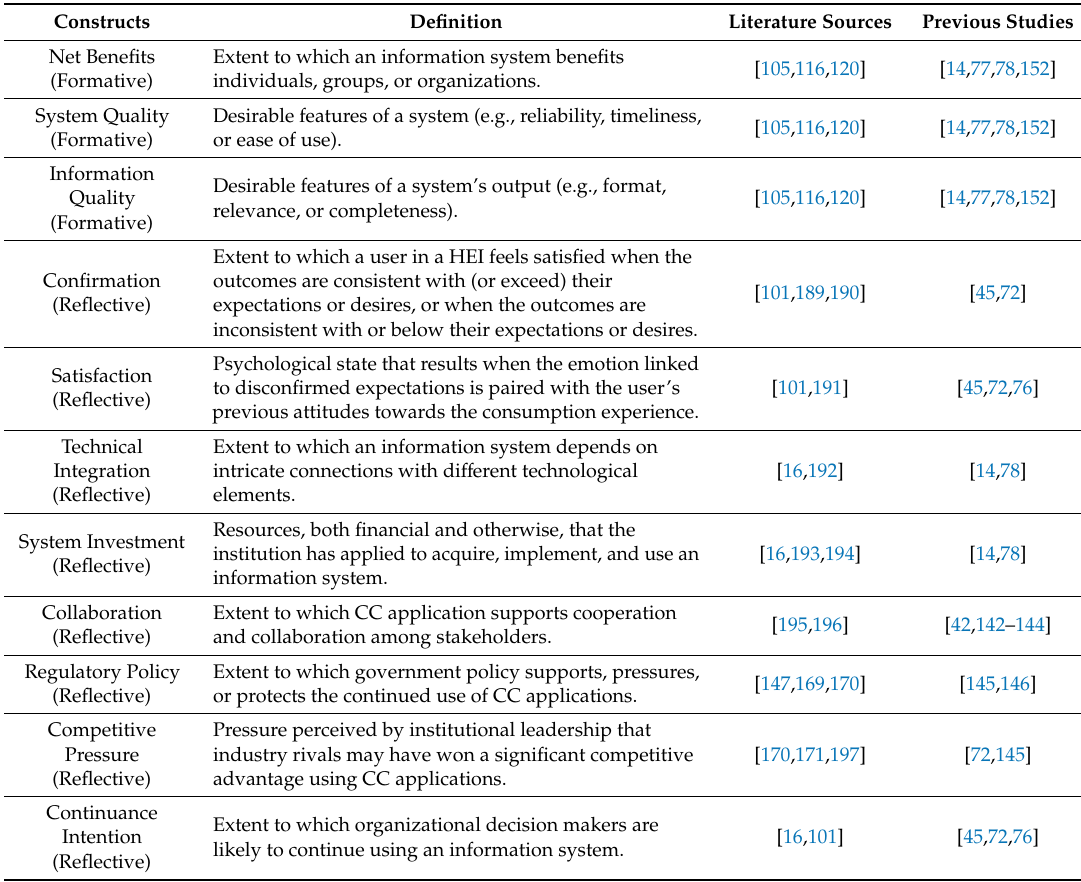
Table 4. Constructs and